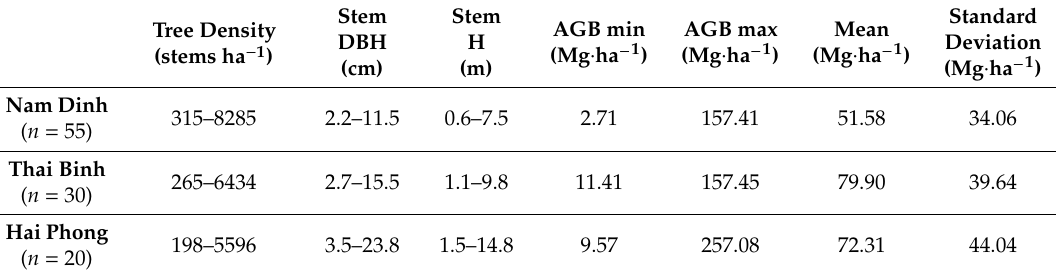
Table 5. Characteristics of the mangrove trees in the RRDBR.